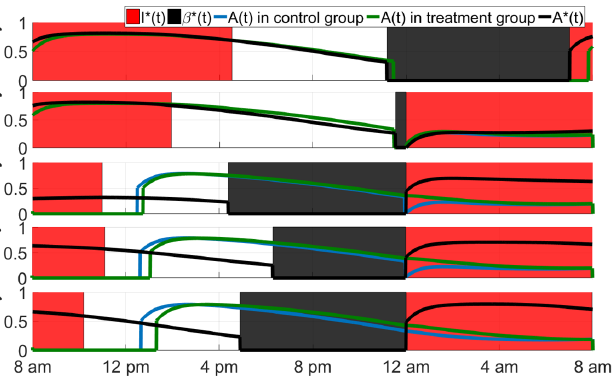
Figure 10. The alertness optimization results in Case1 , where the red and black region show the optimal light I ∗ ( t ) and sleeping period in β ∗ ( t ) . The blue, green, and black curves demonstrate the alertness in the control group, treatment group, and optimal